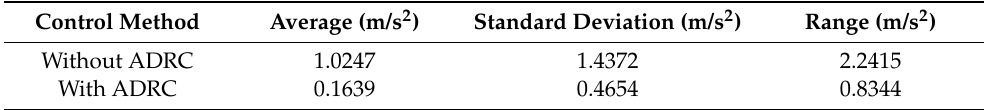
Table 3. Speed error statistics of the host vehicle with 200 kg load and 5 ◦